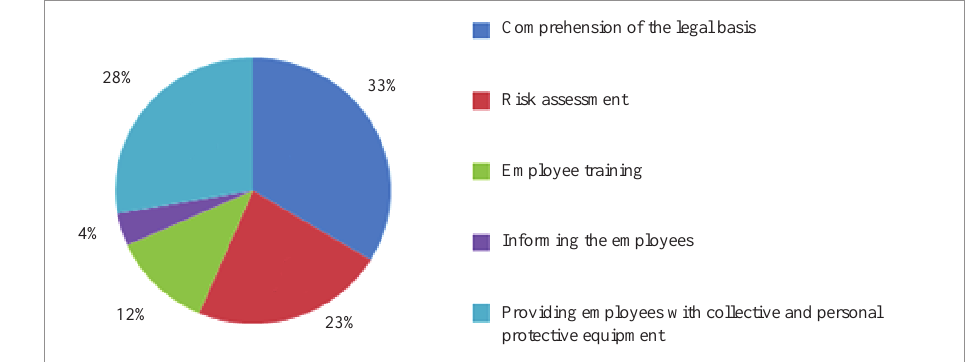
Fig. 7. Problems encountered by construction companies when implementing the requirements of the Directive